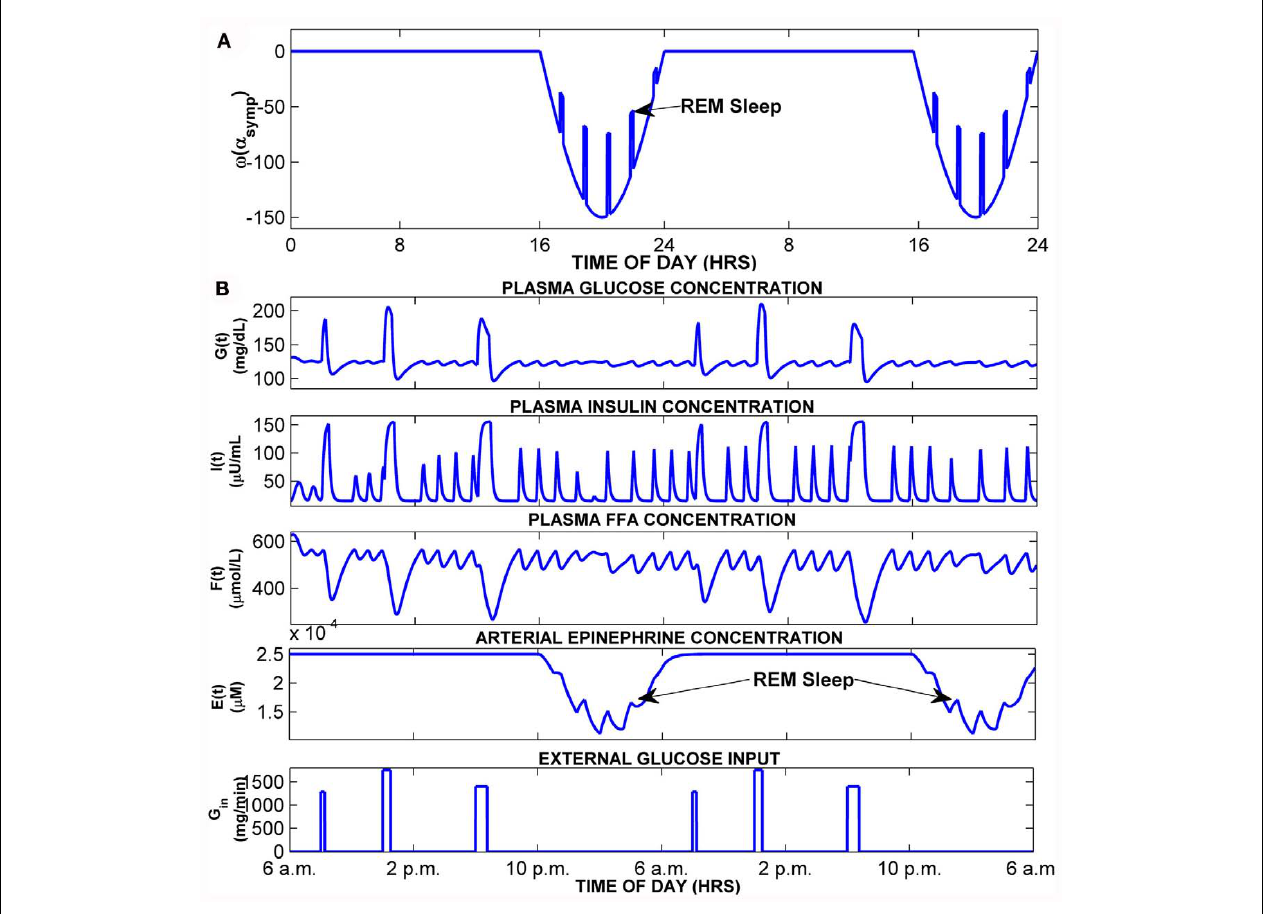
FIGURE 3 | Simulation of normal subject in stand-alone model extension. (A) Time-course of ω ( α symp ), the function that converts changes in alpha-sympathetic activity into changes in epinephrine amount. (B) Model simulation showing 2-day time-courses of blood glucose, insulin, FFA, epinephrine, and external glucose inputs